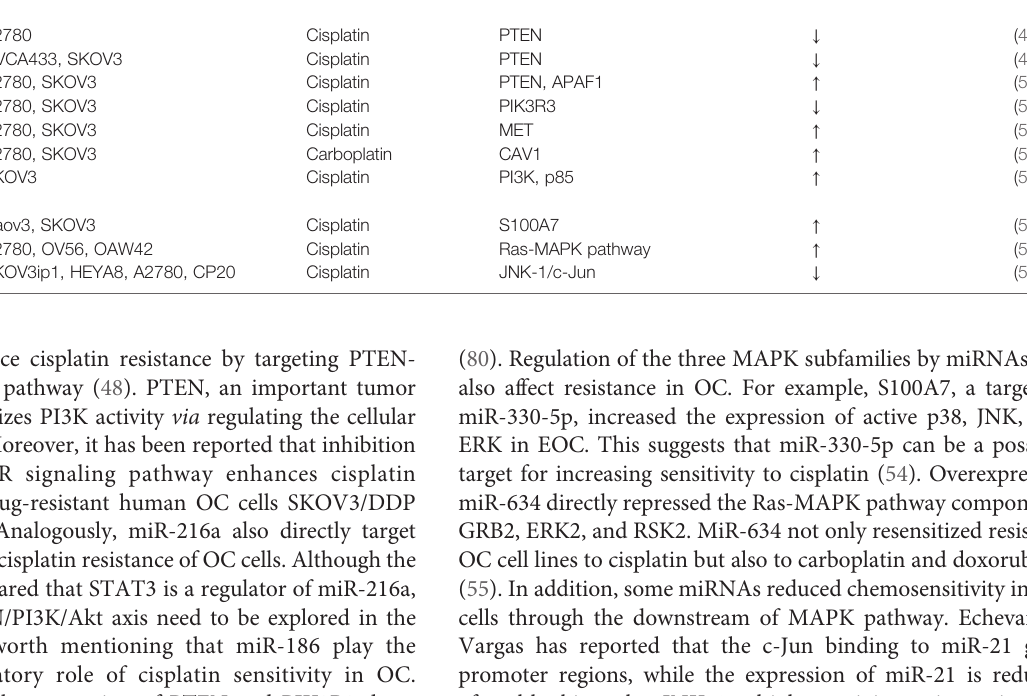
TABLE 4 | Inactivation of apoptosis related pathway and miRNAs in OC.